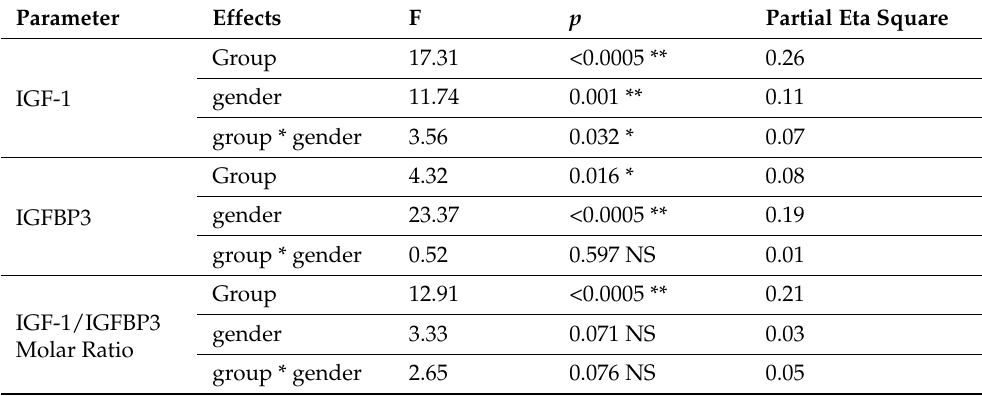
Table 2. Two-way ANOVA relating to main effects and interaction effects of different groups and